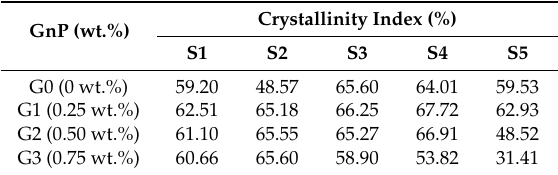
Figure 12. The X-Ray diffractograms of hybrid composites. ( a ) S1; ( b ) S2; ( c ) S3; ( d ) S4; and ( e ) S5. Table 10. The crystallinity index of different laminates.